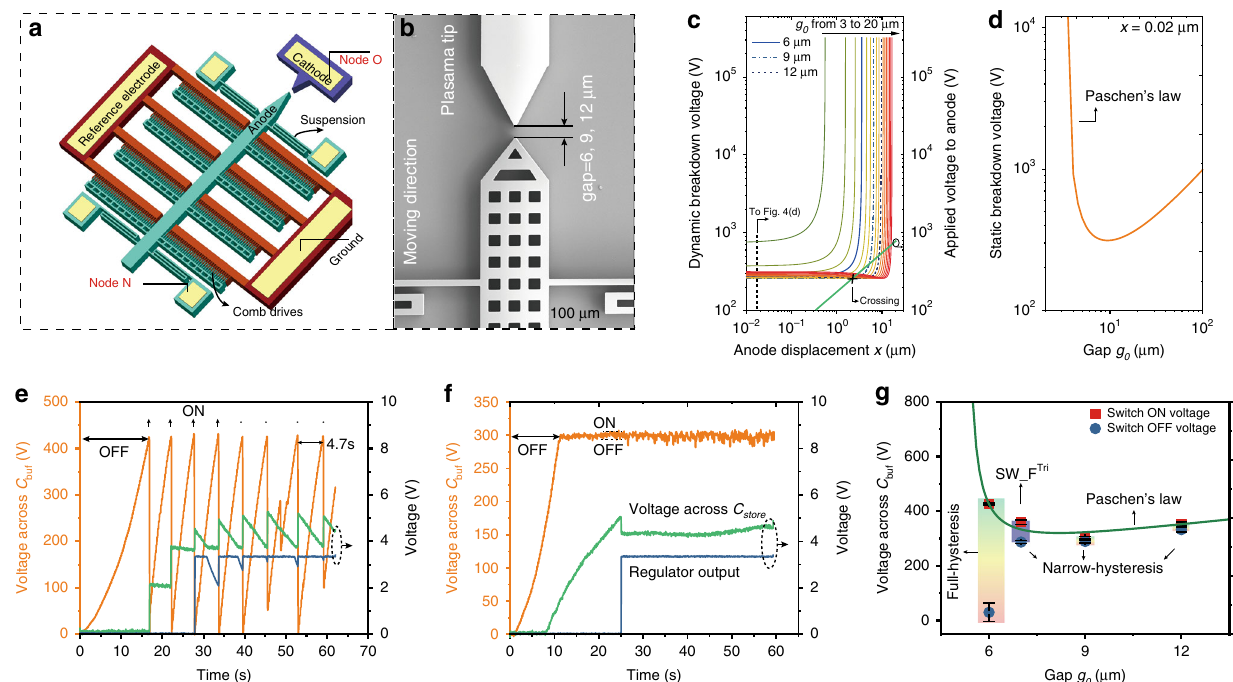
Fig. 4 MEMS movable switch and the corresponding electrical performances. a Schematic of the movable switch. b Scanning electron microscope (SEM) image of the switch. c Calculated dynamic breakdown voltage as functions of the anode displacement ( x ) and the relation between the voltage applied to the anode V C and x (blue curve). d Static calculated breakdown voltage versus gap g 0 with anode displacement of x = 0.02 μ m, which corresponds to the buf section of x = 0.02 μ m in c . Voltage across C buf and C store and the regulator output (blue) when using a movable switch with gap 6 μ m ( e ), and 9 μ m ( f ) in the 2-stage system with a commercial regulator and a load of 660 k Ω . g The switch ON and OFF voltages versus the Paschen ’ s law curve of silicon electrodes. Source data are provided as a Source data fi